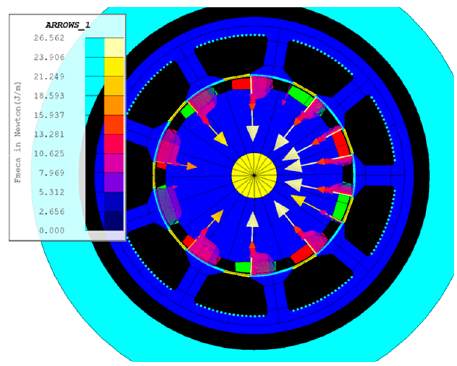
Figure 4. Magnetic force distribution of the for a machine with Q = 9, p = 10.